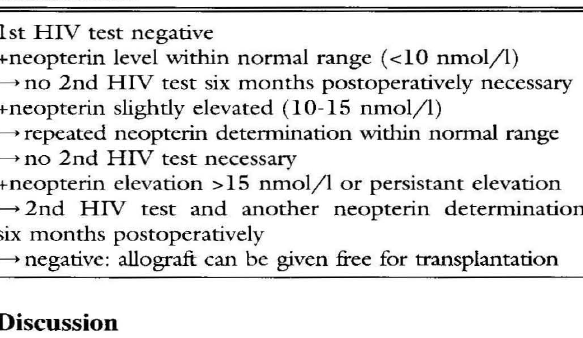
Table 1. Management of bone banking with